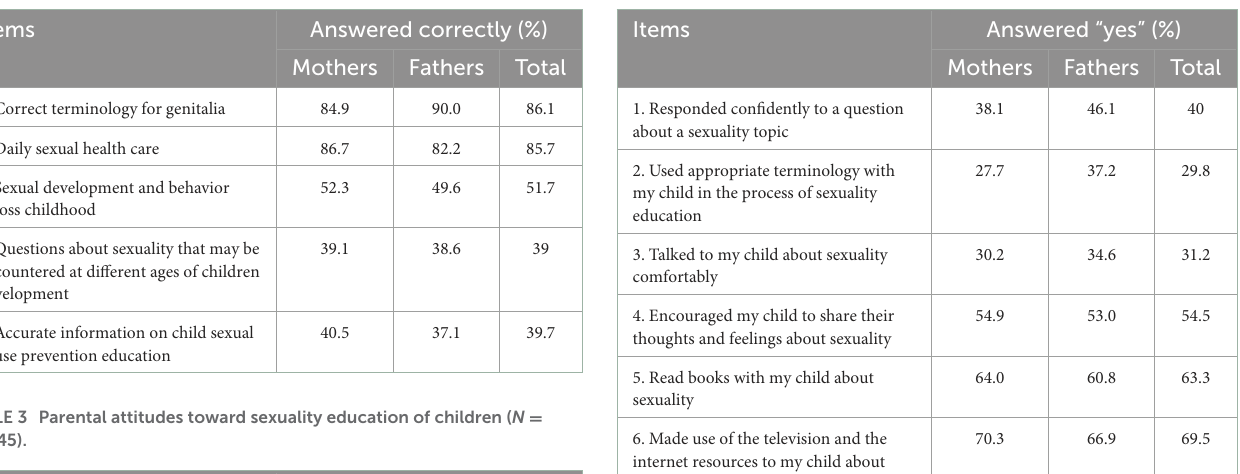
TABLE 4 Parental practices on sexuality education of children ( N =